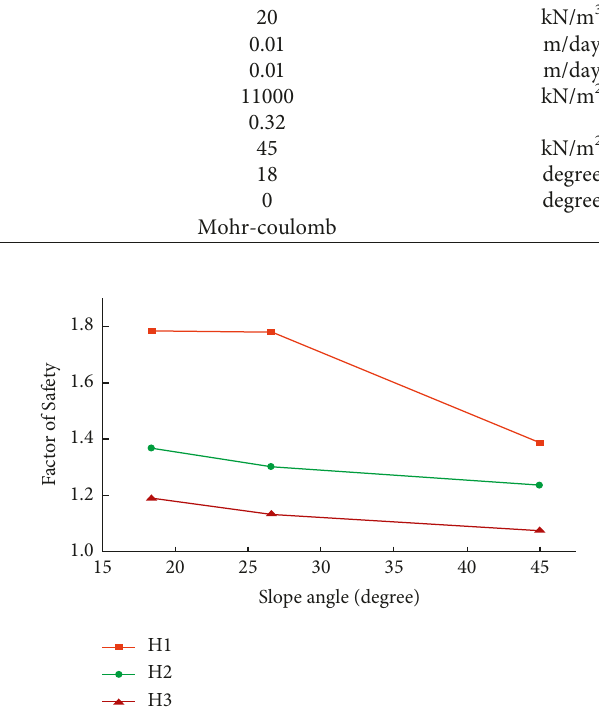
Figure 3: Factor of safety for unreinforced embankment geometry.